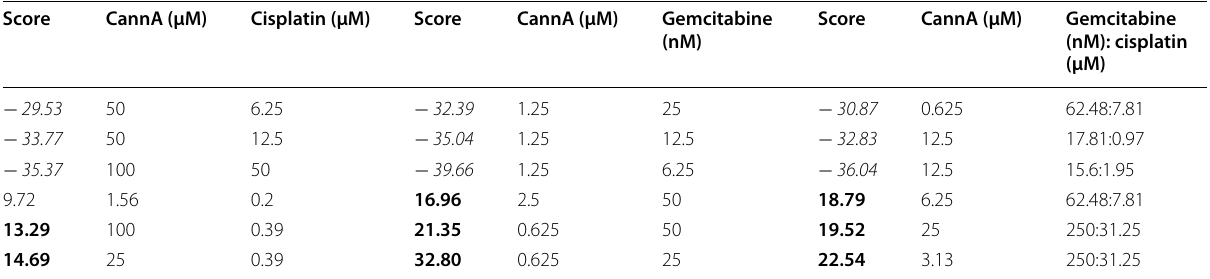
Table 1 Highest and lowest levels of interaction between cannflavin A and gemcitabine and/or cisplatin in T24 cells